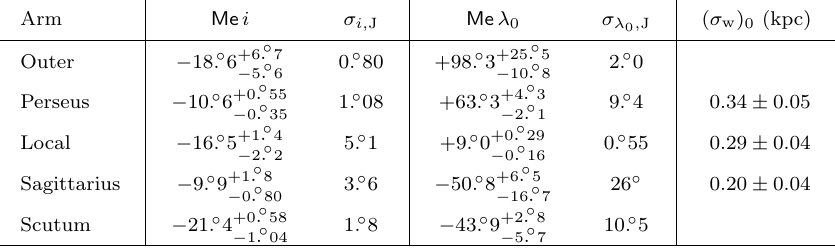
Table 2. Estimates of i and λ 0 for five spiral segments with R 0 = 8 . 44 kpc. Here